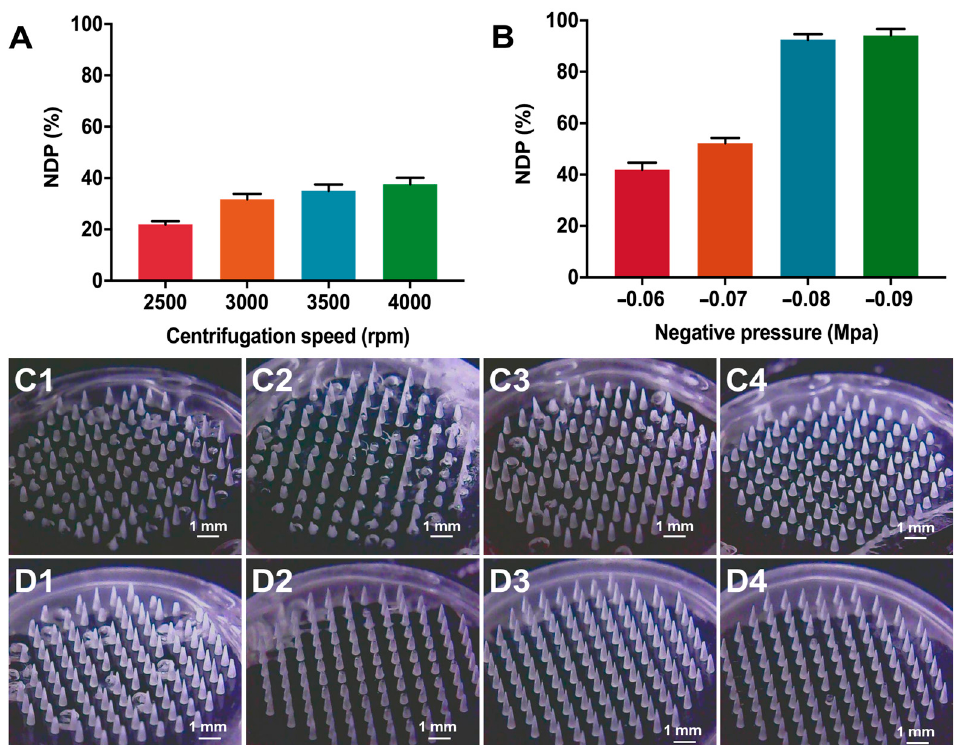
Figure 4. The in fl uence of ( A ) centrifugation speed and ( B ) negative pressure on the DNP of particle-embedded gas-propelled MNs ( n = 3). The morphology of MNs prepared at the speed of ( C1 ) 2500 rpm, ( C2 ) 3000 rpm, ( C3 ) 3500 rpm, ( C4 ) 4000 rpm, or at the negative pressure of ( D1 ) − 0.06 Mpa, ( D2 ) − 0.07 Mpa, ( D3 ) − 0.08 Mpa, ( D4 ) − 0.09 Mpa.